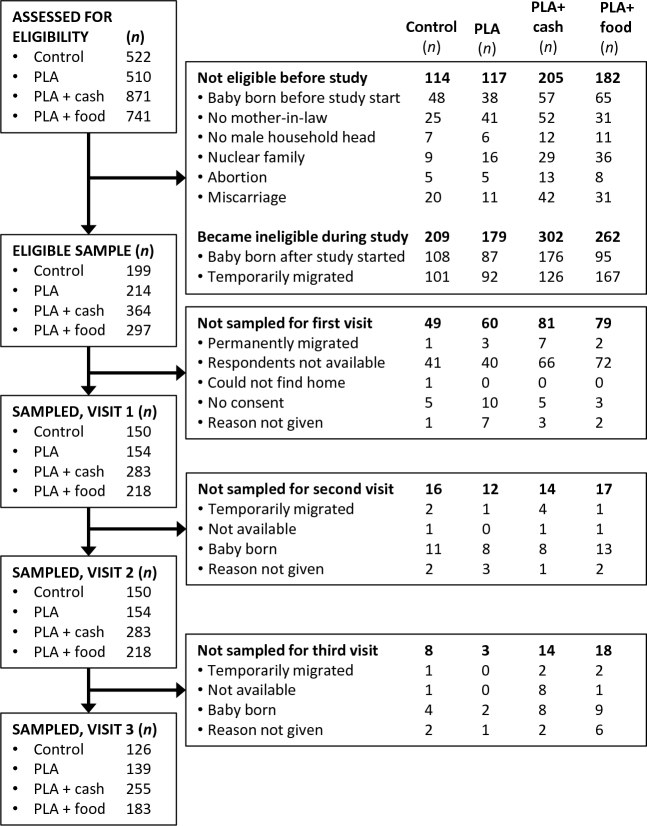
Reasons for nonresponse by trial arm. PLA, Participatory Learning and Action.